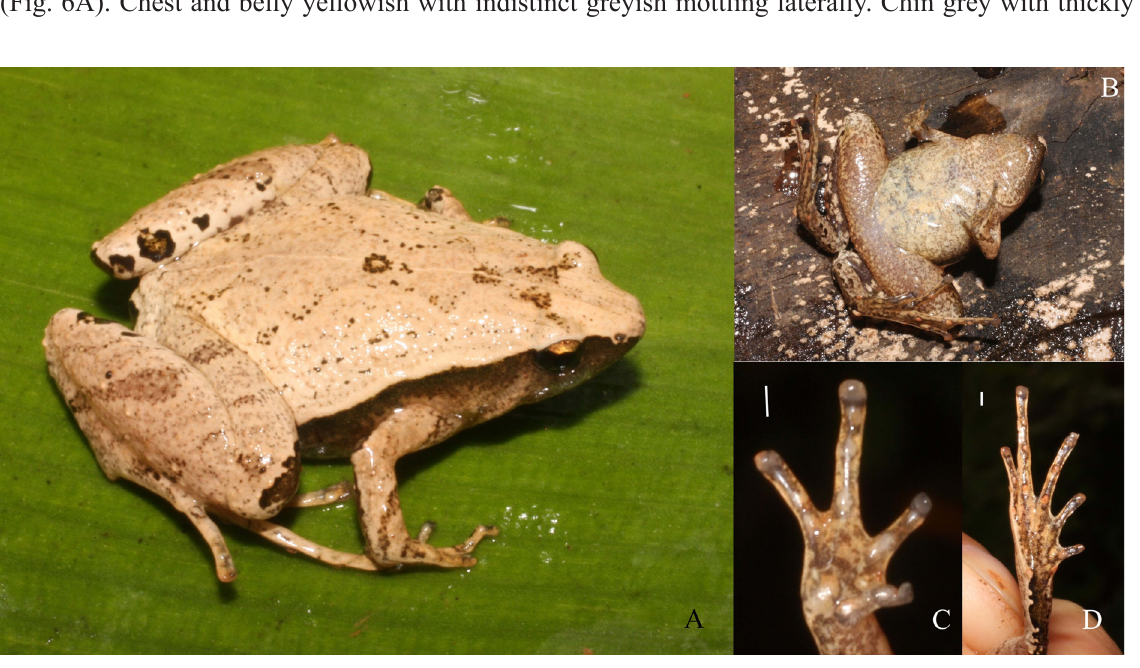
Fig. 6. Microhyla xodangorum sp. nov., ♀, holotype (IEBR A.4913 (KP-MĐ-2018-21)). A . Dorsolateral view in life. B . Ventral view in life. C . Underside of right hand. D . Underside of right foot. Scale bars = 1